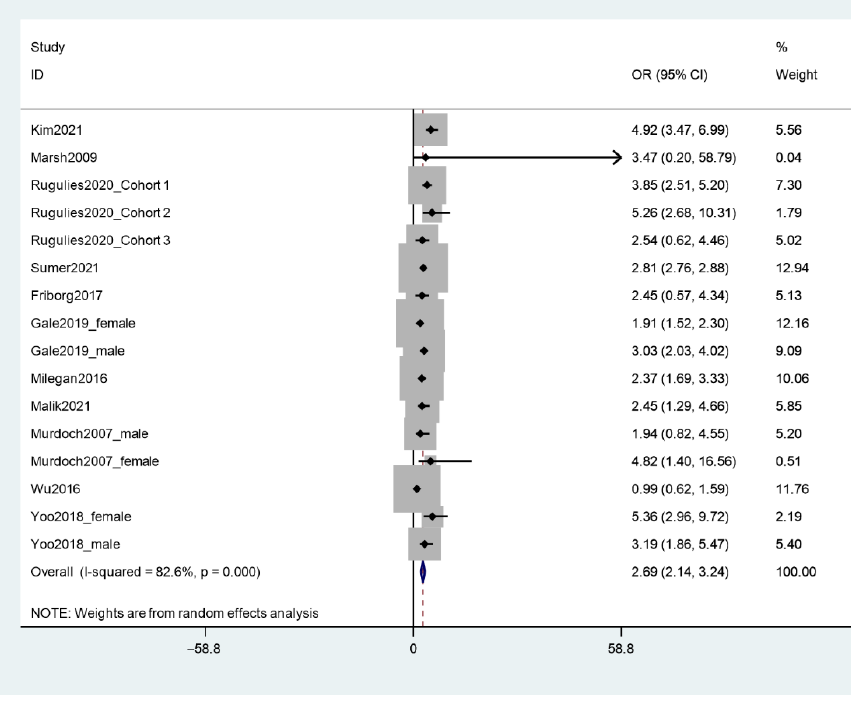
Figure 3. Meta-analysis of odd ratios of depression among workers who experienced SHWP .